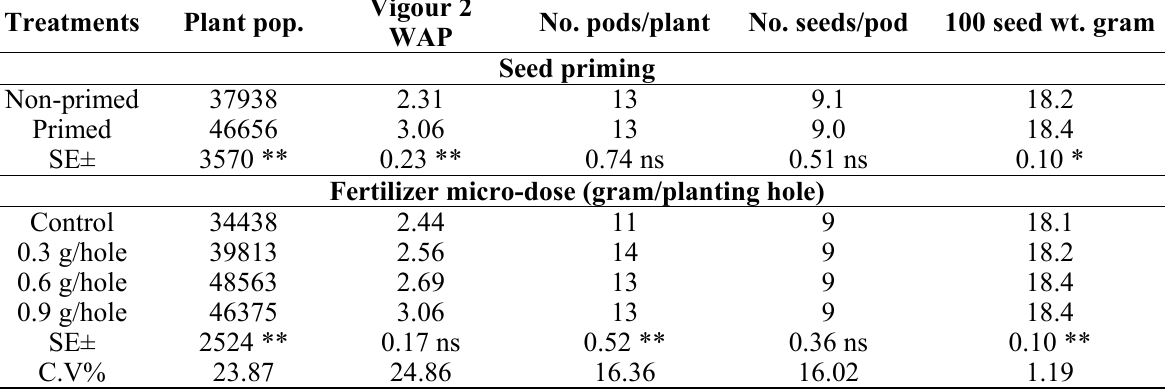
Table 8. Effect of seed priming and micro fertilizing on cowpea combined across two seasons.